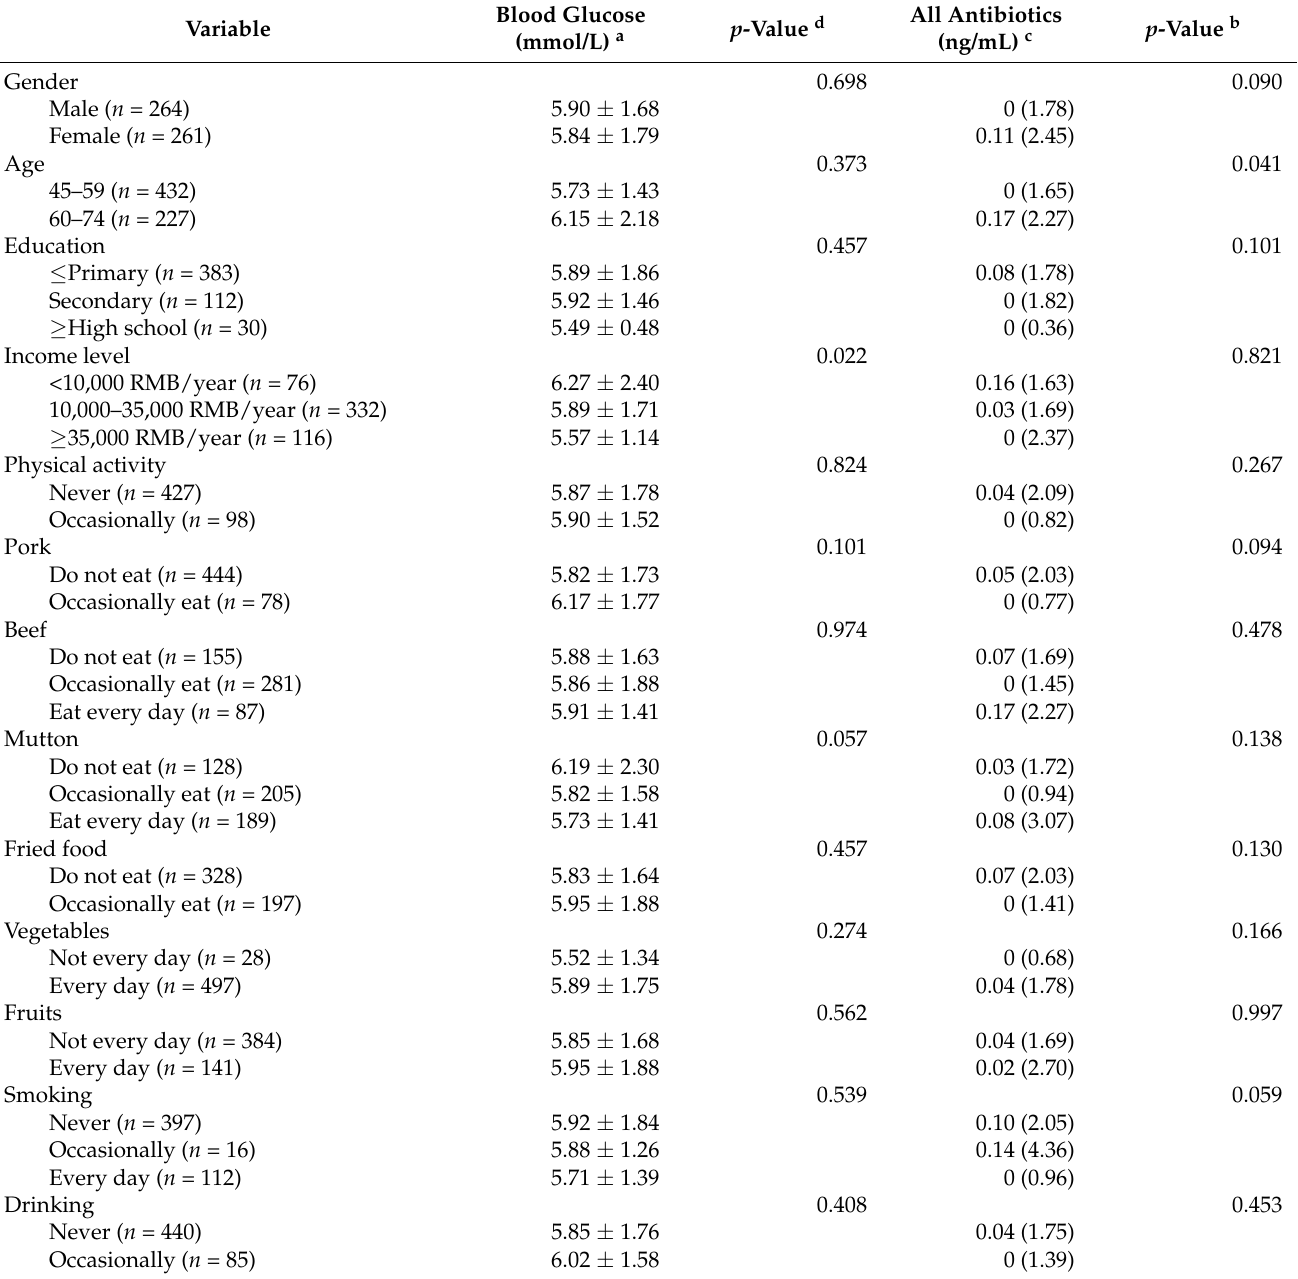
Table 4. Blood glucose and all antibiotics in relation to demographic variables.